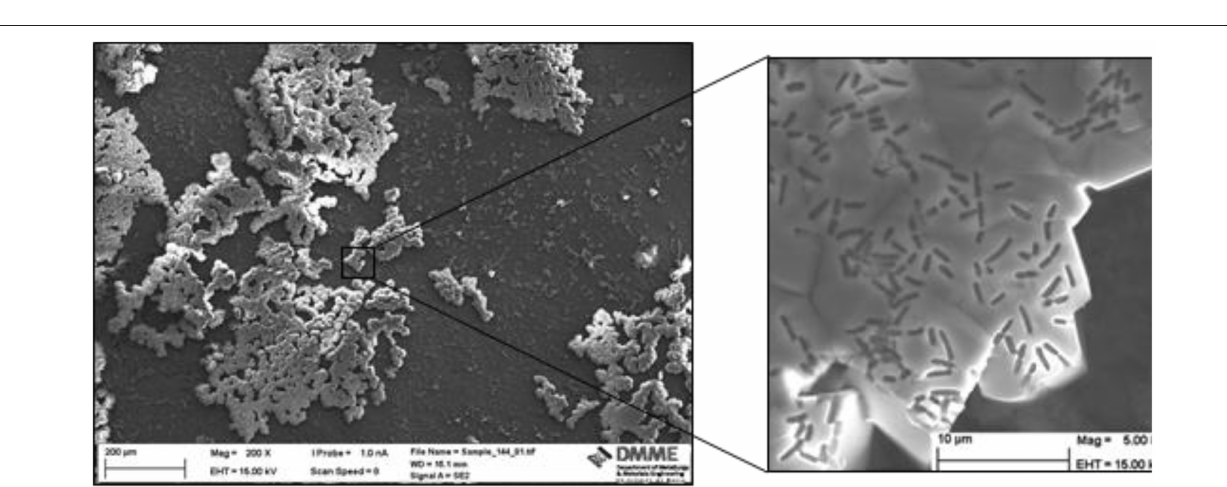
FIGURE 4 | SEM image for sample 1bAc7 treated with L. sphaericus and calcium acetate at 200X (left) and 5,000X magnification (right). The outline of the microbes embedded in the calcite biodeposition is clearly visible in the enlarged